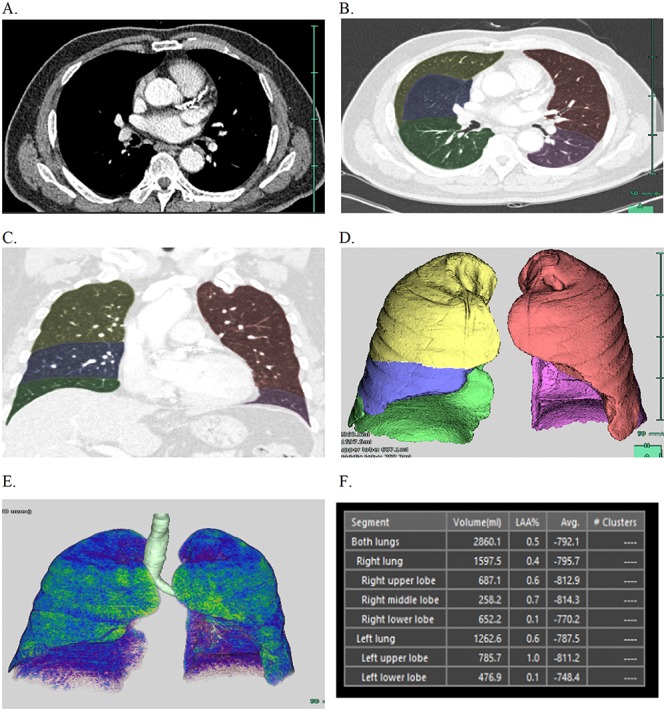
Process of obtaining emphysema index and lobe-specific emphysema index.Computed tomography image (A) is converted to a three-dimensional volume rendering image using a commercially available software, Synapse 3D Vincent™. Lobes are divided via the automatic segmentation technique and manual correction (B, C), and the volume of each lobe is produced (D). Lobe-specific emphysema index for each lobe is obtained by defining the emphysema index with an attenuation value lower than -950 Hounsfield unit (E, F).